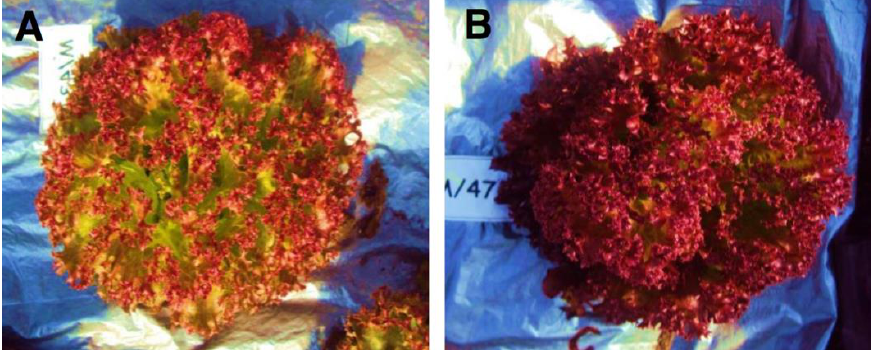
Figure 7. The general appearance of Lollo Rosso at harvest grown under UV-blocking film ( A ) or UV-transparent film ( B ). Note the difference in quality in the lettuce head. UV-transparent film ( B ). Note the difference in quality in the lettuce